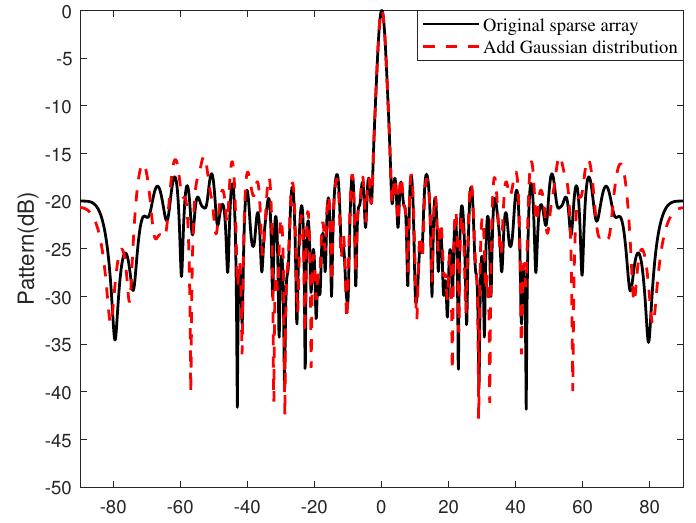
Figure 21. The beampattern after position